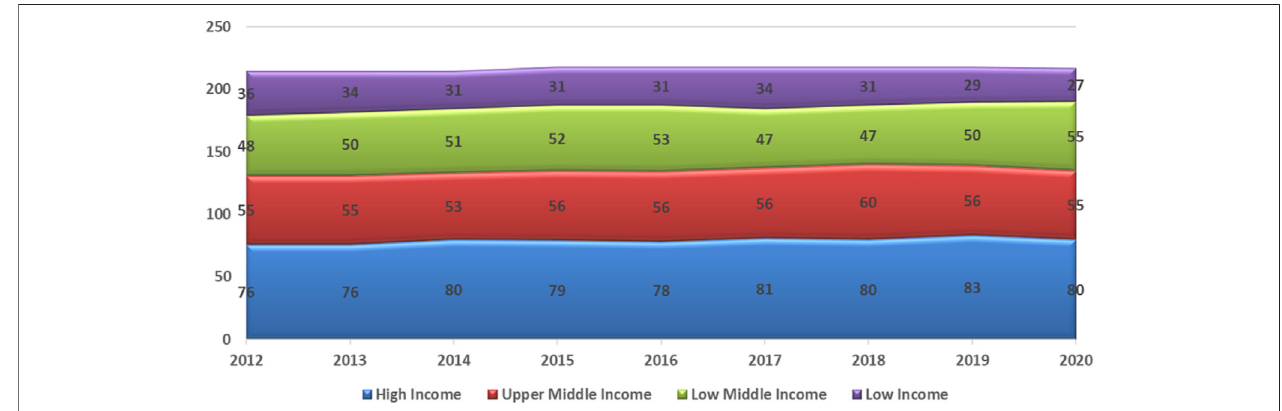
FIGURE 1 | Change of income level in all countries from 2012 to